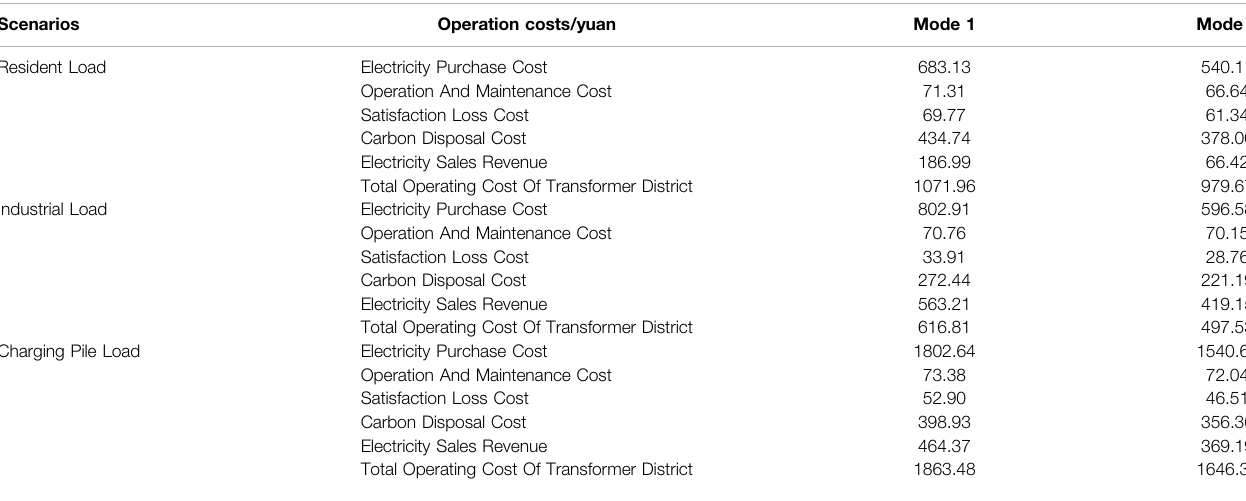
TABLE 4 | Optimal scheduling costs in three scenarios under two modes.